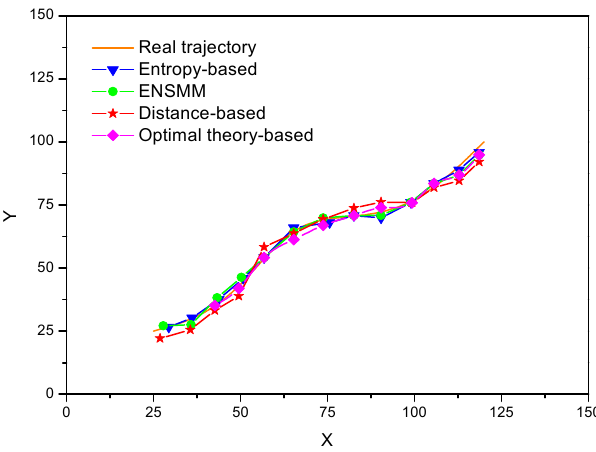
Figure 7. The estimated target trajectory in different methods.